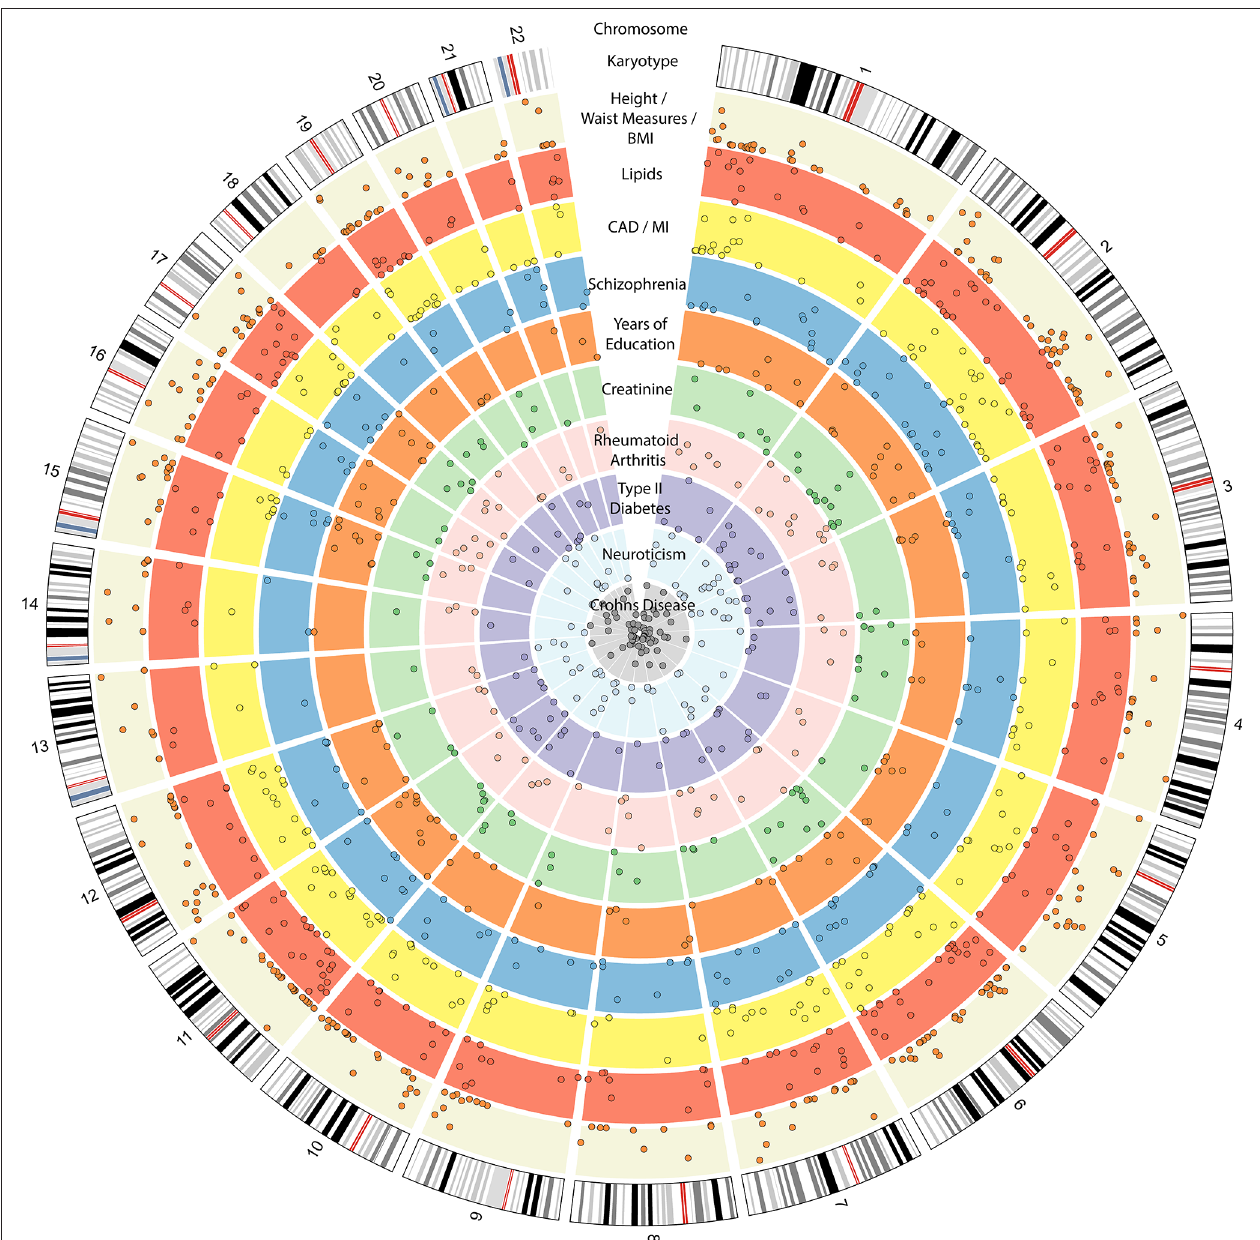
FiGuRe 1 | Circos plot showing the 10 traits from the GWAS catalog (37) with the largest number of loci also associated to BP, as identified by PhenoScanner (38) at p < 0.05 ( Supplemental Methods ). The outer ring represents the genomic/chromosomal location (hg19). The following inner rings show the associations to different traits. Beige: body measurements (height, body mass index (BMI), weight, waist/hip ratio, hip circumference, waist circumference. N = 358). Red: lipids (high-density lipoprotein (HDL), low-density lipoprotein (LDL), triglycerides, total cholesterol. N = 226). Yellow: coronary artery disease (CAD)/myocardial infarction (MI) ( N = 206). Blue: schizophrenia ( N = 135). Orange: years of education attendance ( N = 101). Light green: creatinine ( N = 88). Light pink: rheumatoid arthritis ( N = 78). Purple: type II diabetes ( N = 73). Light turquoise: neuroticism ( N = 69). Light grey: Crohn’s disease ( N =